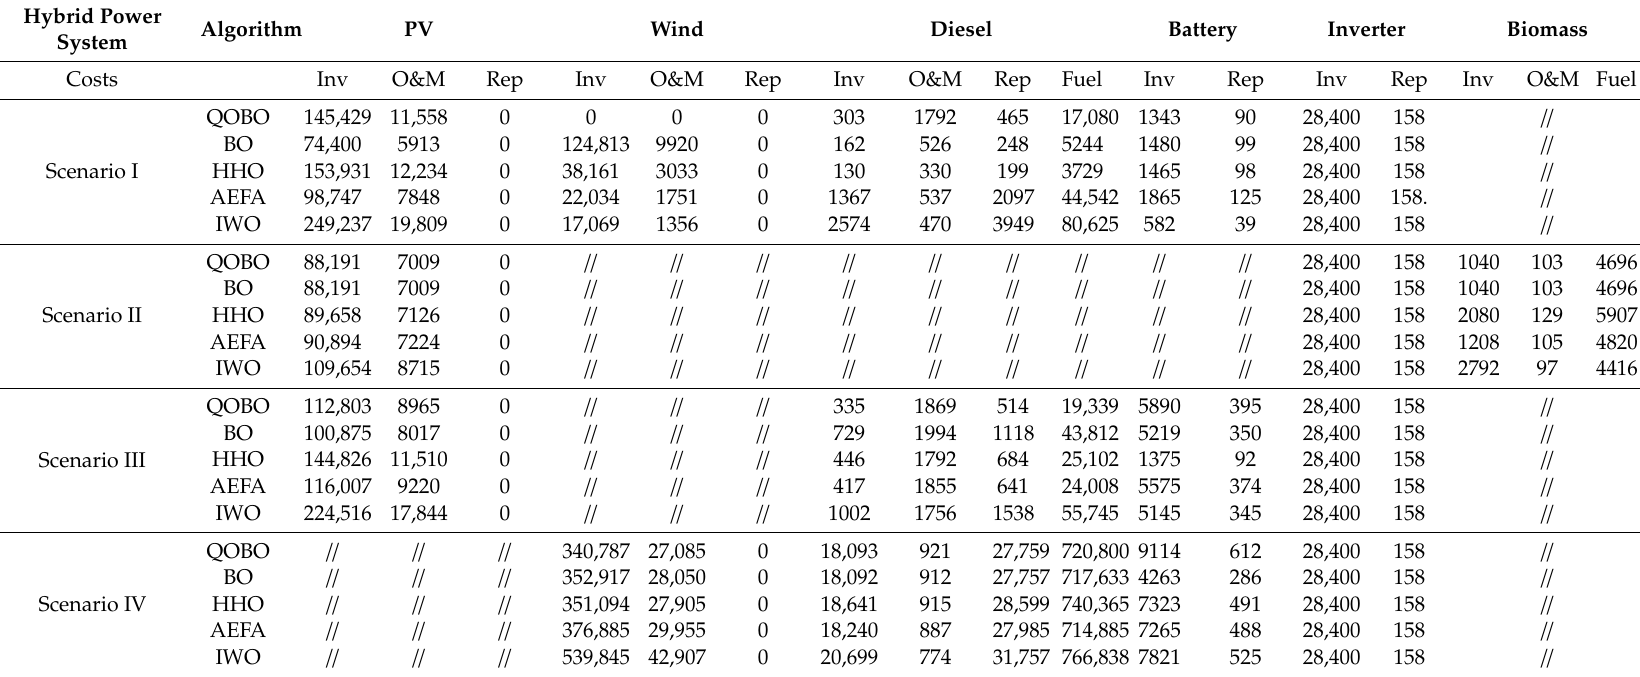
Table 4. Convergence of objective function of di ff erent